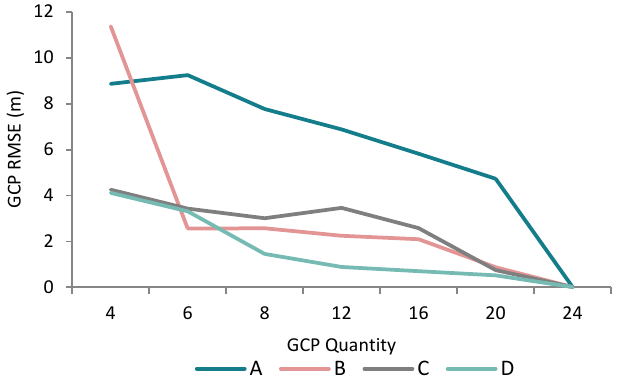
Figure 4. Total GCP RMSE of the four configuration class